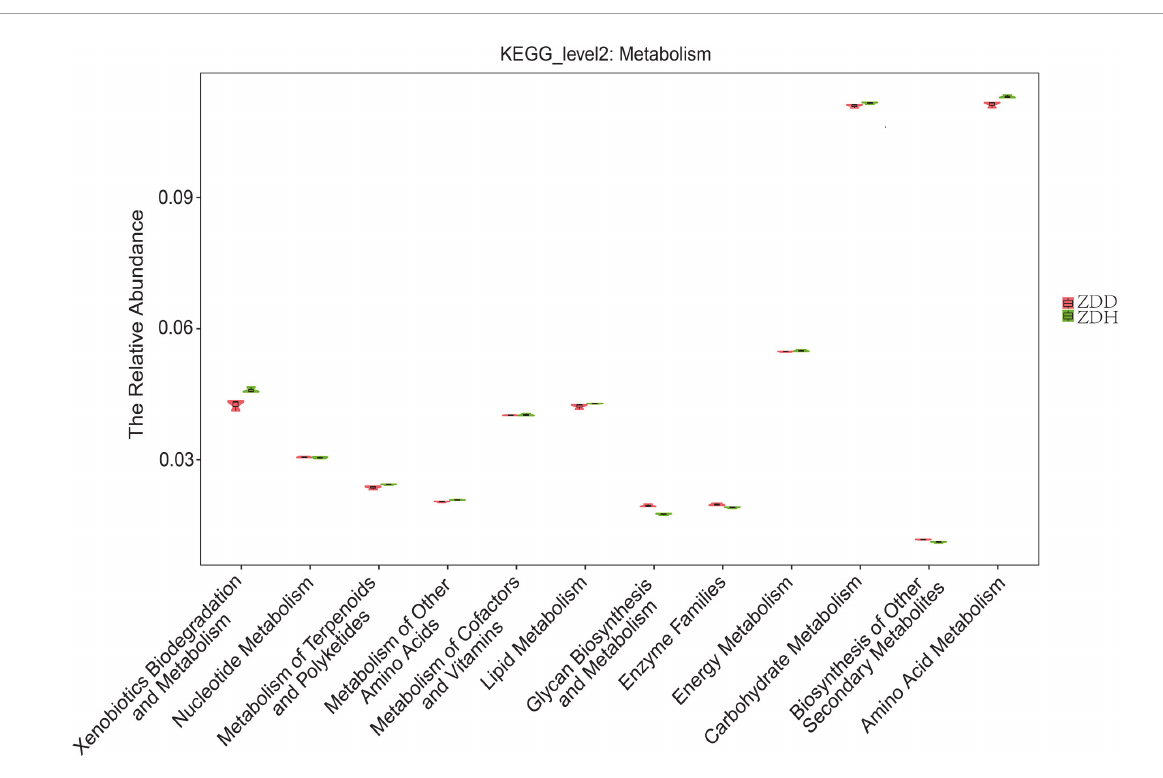
samples included Sphingomonas, Gemmatimonas, Burkholderia- Paraburkholderia, Jatrophihabitans, Nitrobacter, Roseiflexus and Streptomyces ( Figure 2B ). Sphingomonas, Gemmatimonas, Burkholderia-Paraburkholderia and Jatrophihabitans were the most dominant genera. The top nine most abundant fungi phyla